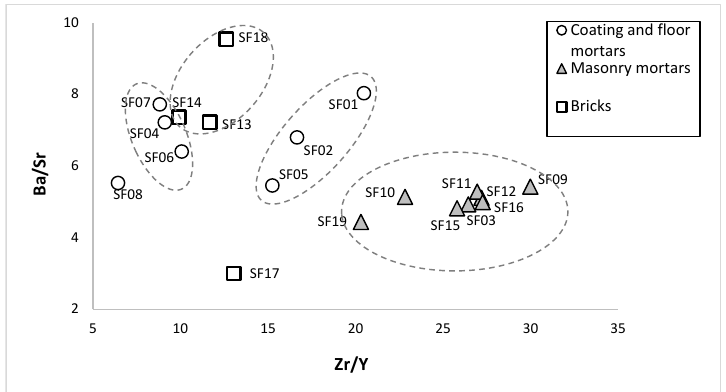
Figure 9. Mortars and bricks Ba/Sr vs. Zr/Y binary diagram.